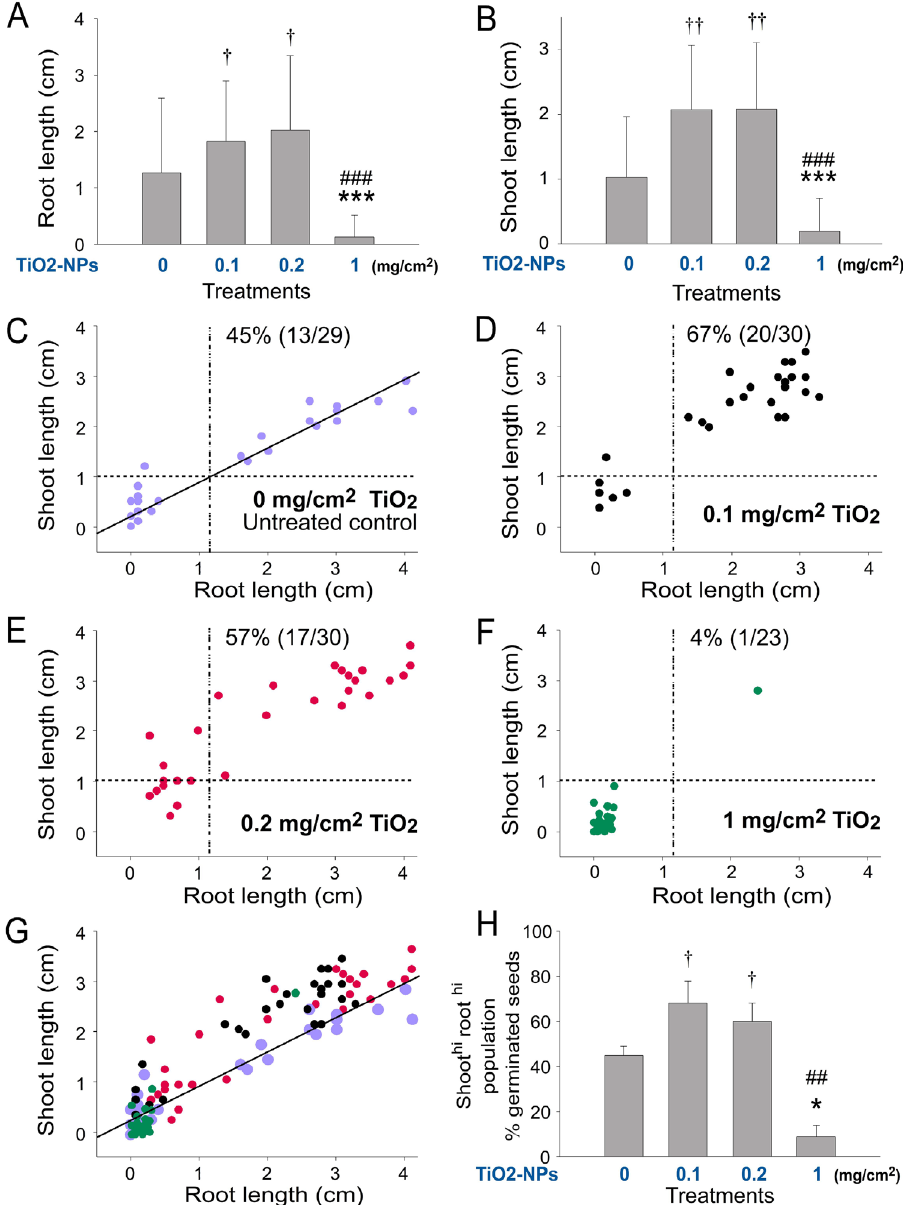
Figure 2. Soil TiO 2 NP levels affected the seedling growth of Amaranthus mangostanus. Analyses of root ( A ) and shoot ( B ) length of 1-week-old Amaranthus mangostanus seedlings. Root–shoot 2D graphs of the seedling without ( C ) and with different doses of TiO 2 NP treatments ( D–F ), and an overlay ( G ) are shown. The regression lines of untreated groups were indicated ( C , G ). The shoot hi root hi population (upper-right quadrant) of seedlings in each condition was quantified ( H ). The vertical and horizontal dotted lines in ( C–F ) are the mean values of root length and shoot length of the untreated control groups ( C ), respectively. † P < 0.05, †† P < 0.01, * P < 0.05, *** P < 0.001 vs. 0 mg/cm 2 TiO 2 untreated groups; ## P < 0.01, ### P < 0.001 vs. respective 0.2 mg/cm 2 TiO 2 groups. n = 90 (3 independent experiments; each experiment with 30 seeds) ( A,B ). n = 30 (3 independent experiments; each experiment with 10 seeds) ( C–G ). n = 3 (3 independent experiments; each experiment with 30 seeds) ( H